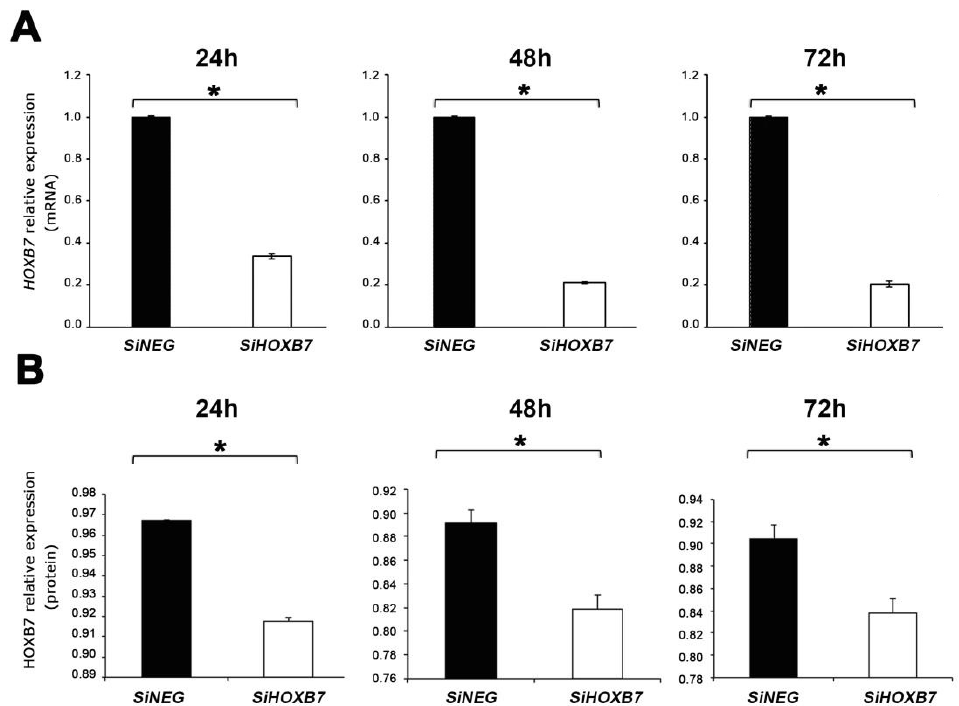
Figure 1. HOXB7 expression in MDA-MB-468 cells transfected with siHOXB7 and control siNEG F igure 1 evaluated by RT-qPCR ( A ) and western-blot ( B ) analyses at 24, 48, and 72 h (h) post-transfection (three replicates). Statistical analyses and significant differences are indicated with asterisks based on Test- t analyses (*, p < 0.001). Expression differences between time points were compared using the post hoc Tukey test. The HOXB7 mRNA levels were approximately 70% lower in HOXB7-silenced cells than in the controls, and the protein levels were also lower in the HOXB7-silenced cells just detectable at 24 h and 48 h post-transfection. In the western-blot analyses, β -tubulin was used as the reference